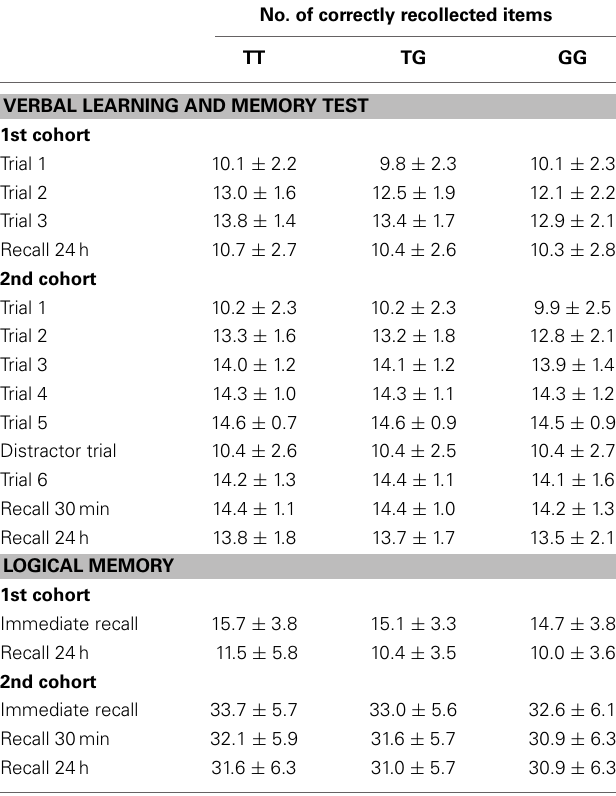
Table 2 | Statistics of the behavioral